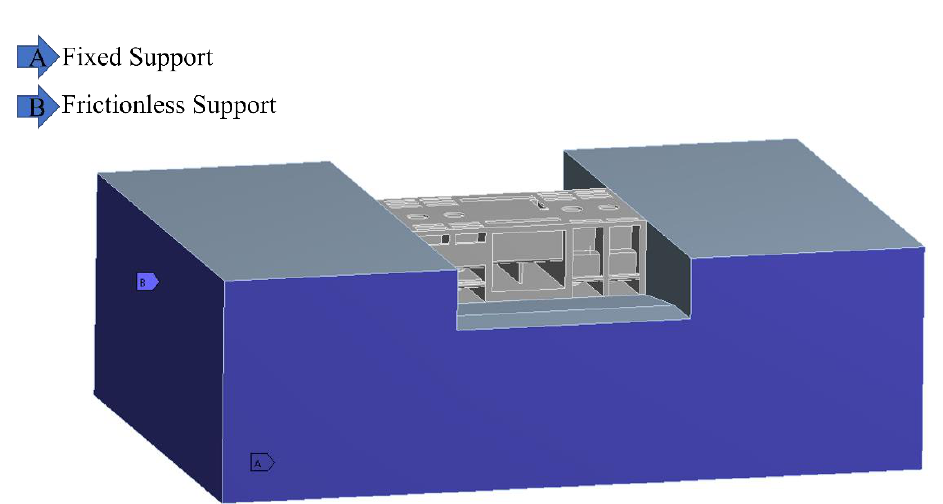
Figure 6. Schematic diagram of the boundary condition setting of the station building.